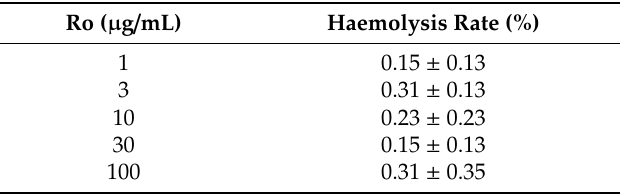
Figure 9. Haemolysis test result of Ro. Table 2. Haemolysis rate of Ro at different concentrations.